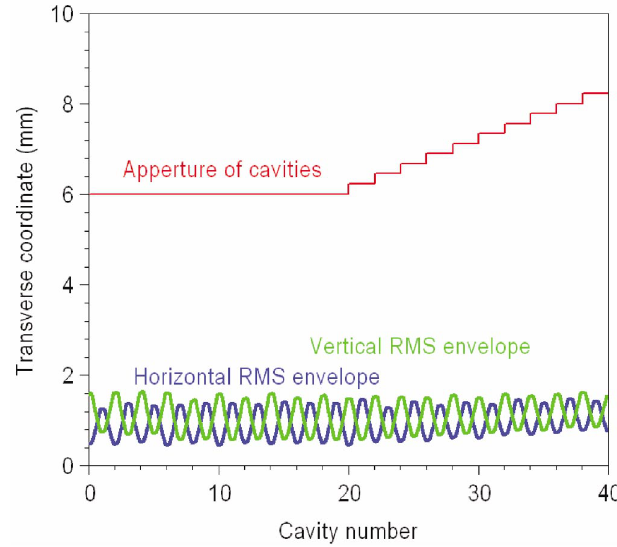
FIG. 28. (Color) rms transverse sizes of the beam at 40 mA vs cavity